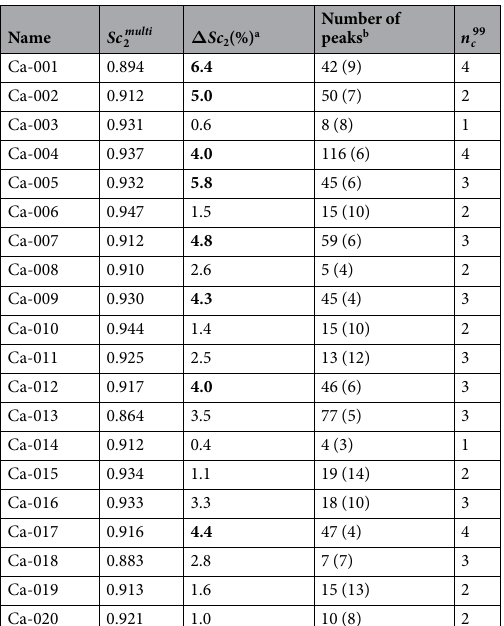
2 Table 2. Summary of combinational analysis of integrins in Ca 2 + solution. a − × Sc Sc Sc ( ) 100 multi 2 2max 2max  , where Sc 2max is listed in Table 1. Values larger than 4 are written in bold. b The number of peaks whose coefficients ( c p ) were larger than 0.01 is given in